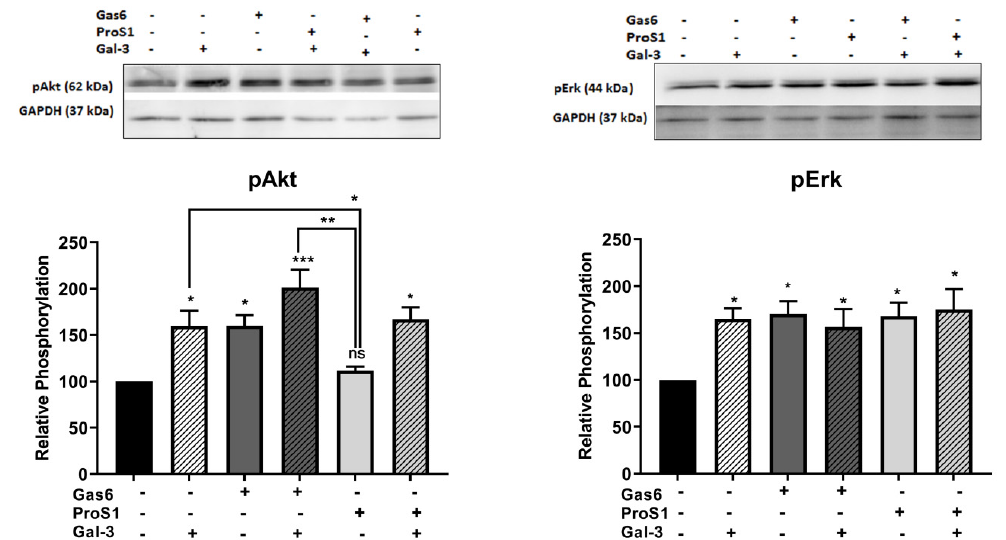
Figure 4. Representative Western blots showing levels of phosphorylated Akt (pAkt) and Erk (pErk) proteins in SCC-25 cells, following addition of Gas6 (5.7 nM), ProS1 (7.5 nM) and Gal-3 (0.2 µ M), either alone or in combination, as indicated by the labelling. Densitometric quantification is shown below. Data are the mean ± SEM protein expression normalised against the loading control protein GAPDH ( n = 3 experiments). ANOVA with Tukey’s multiple comparison post-hoc analysis. * p < 0.05, ** p < 0.01, *** p < 0.001 and ns, not significant vs. the control or between treatments indicated by lines.